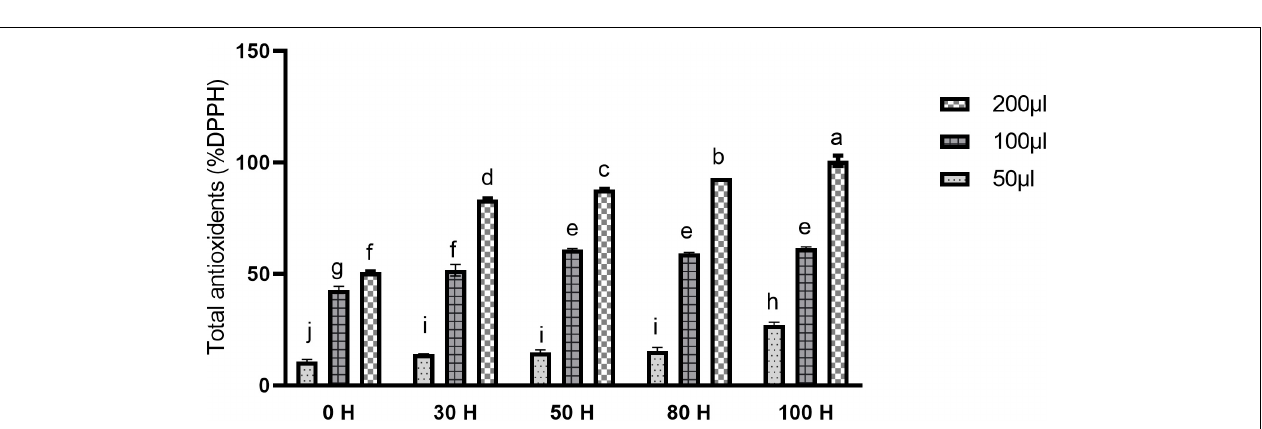
FIGURE 10 | (A) Effect of LED light on anthocyanin contents in pulp (CGE/100 g) in sweet cherry cv. “Van.” (B) Effect of LED light on anthocyanin contents in peel CGE/100 g) in sweet cherry cv. “Van.” (C) Effect of LED light on color enhancement (L*, C*) sweet cherry cv. “Van.” Data are average ± SE. Different letters represent the significant difference between different time periods at 0.05 probability level (LSD test).